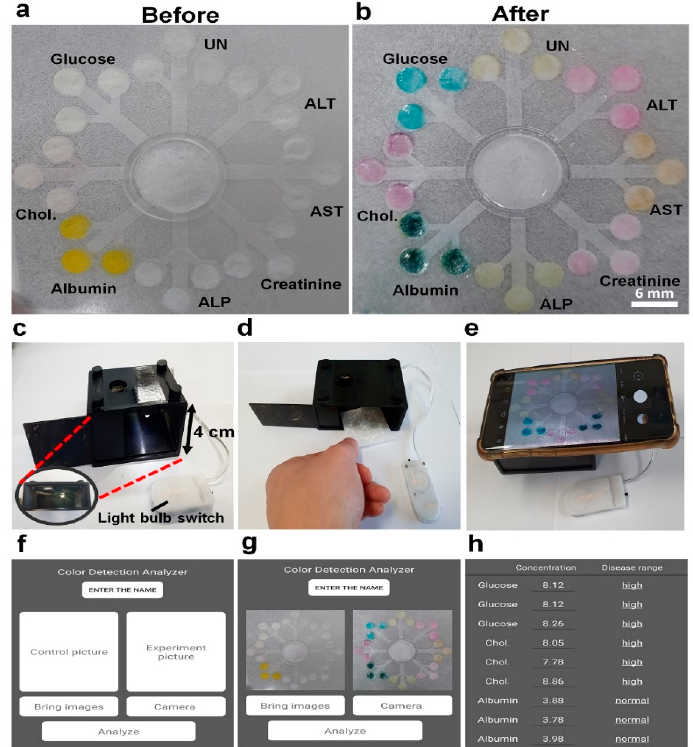
Figure 5. Schematics for detection of multiple biomarkers on the 3D- µ PADs in the photo box using the smartphone application. ( a ) Each enzyme is fixed on each detection zone before loading the